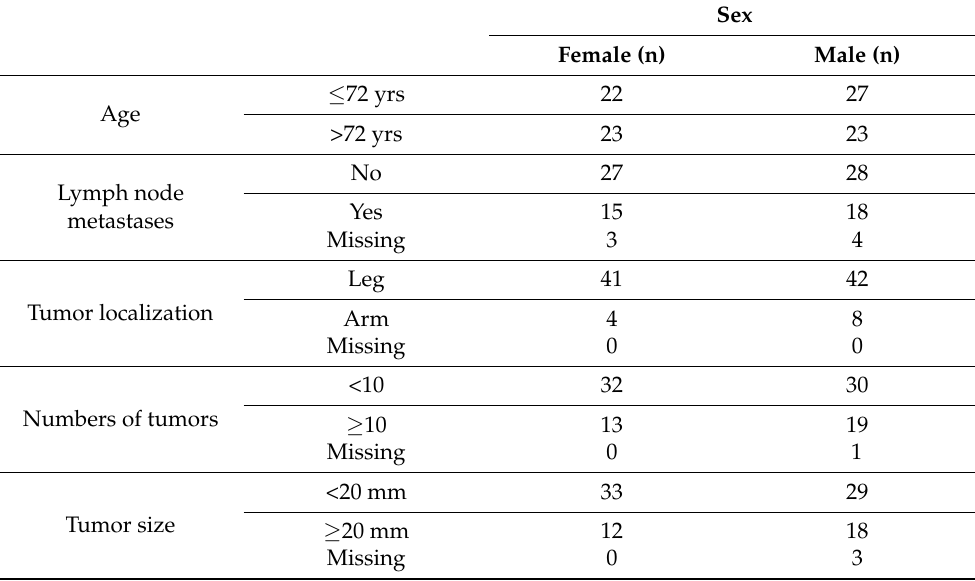
Table 1. Patient characteristics and tumor